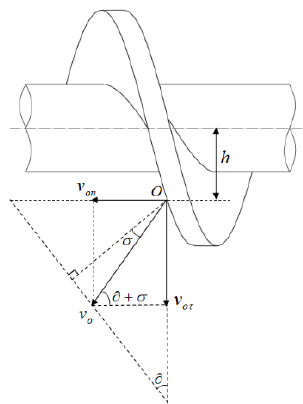
Figure 3. Seed particle velocity decomposition diagram.